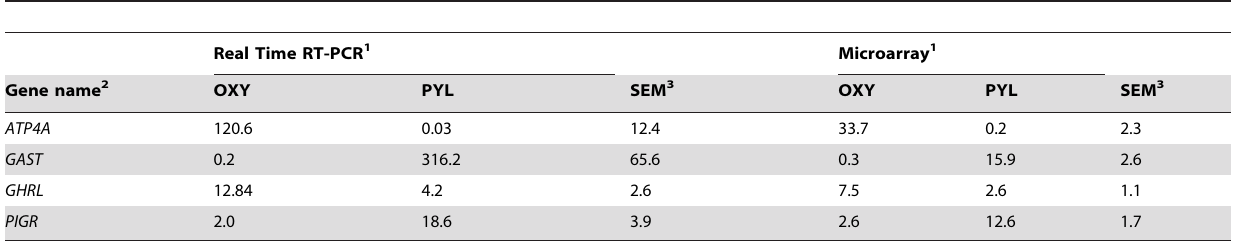
Table 6. Validation of the microarray data by quantitative real-time PCR (qRT-PCR) analysis of four representative